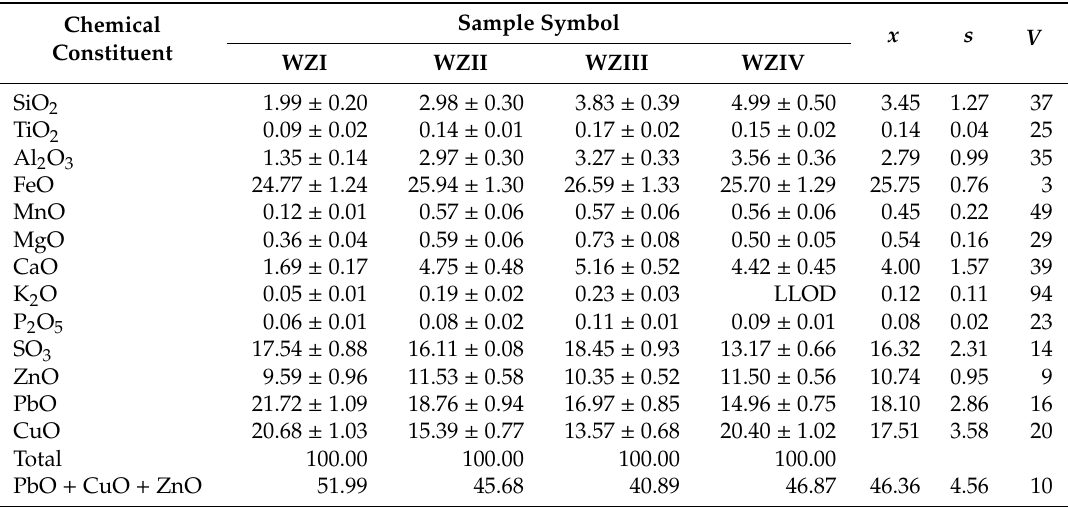
Table 1. The chemical composition of the investigated samples WZI, WZII, WZIII and WZIV (in wt